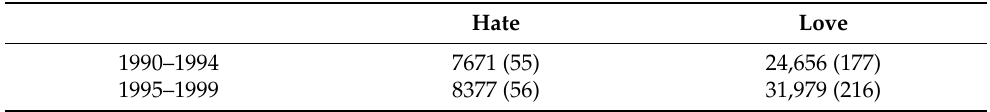
Table 6. Frequencies of hate and love in the years 1990–1994 and 1995–1999 in COCA (relative frequencies per 1m words between